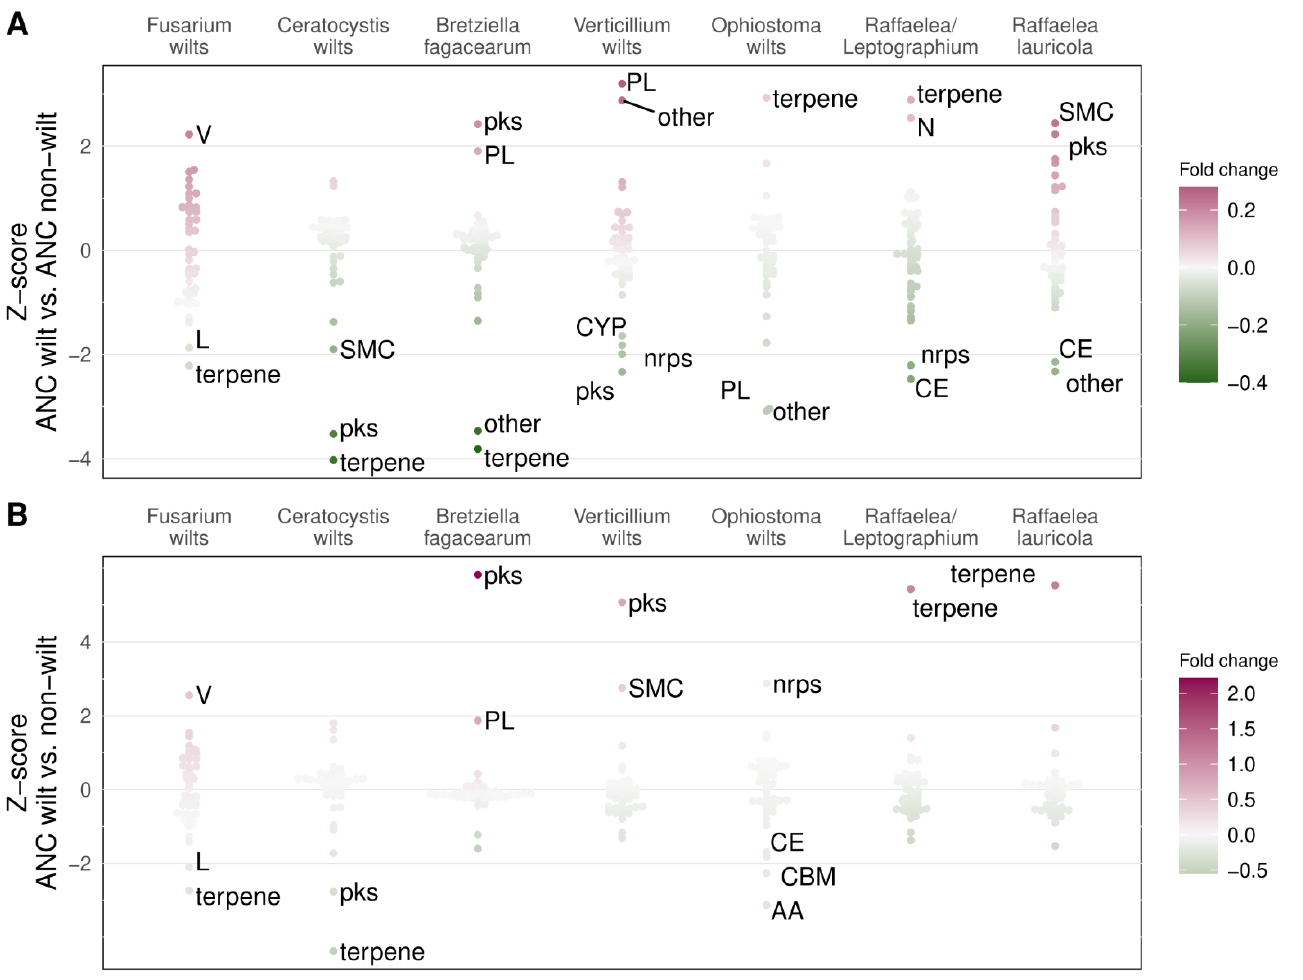
Figure 4. Normalized gene count ratios for gene classes in wilt-causing species (ANC wilt) vs. their non-wilt-causing most recent common ancestors (ANC non-wilt, ( A )) or sister non-wilt species (non-wilt, ( B )) in seven wilt groups. V — defense mechanisms; L — replication, recombination, and